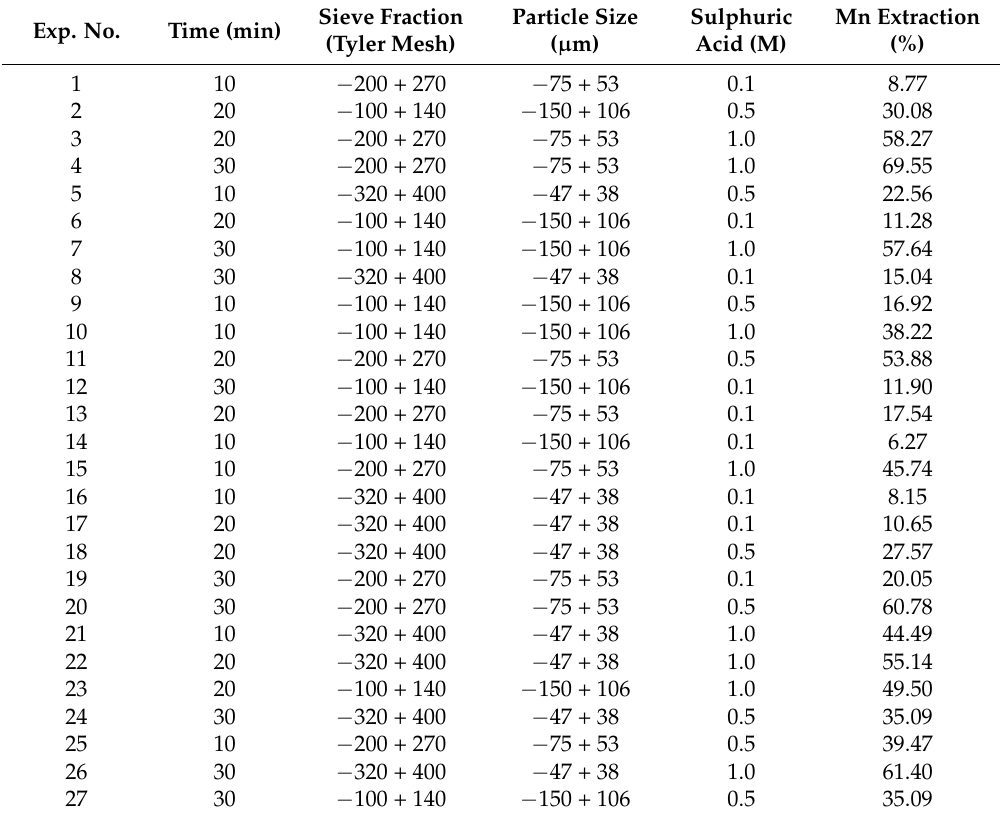
Table 4. Experimental configuration and Mn extraction